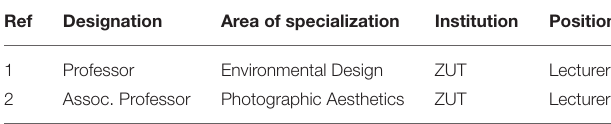
TABLE 1 | List of two experts for stimuli